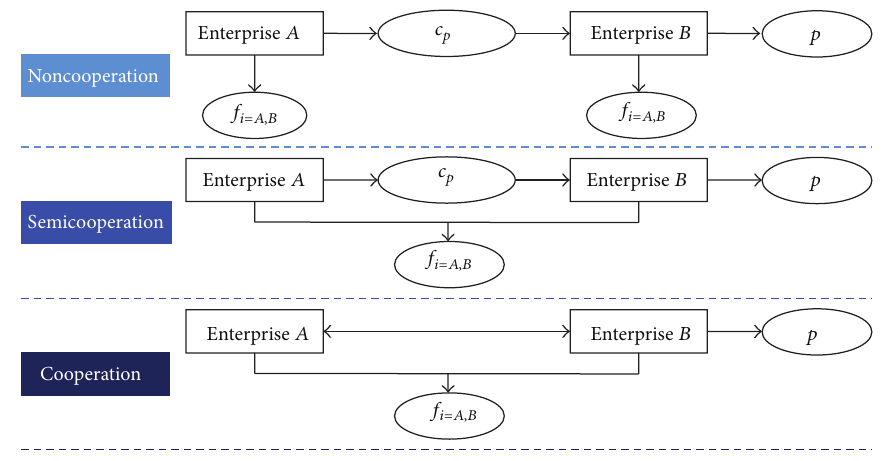
Figure 1: The game process of three